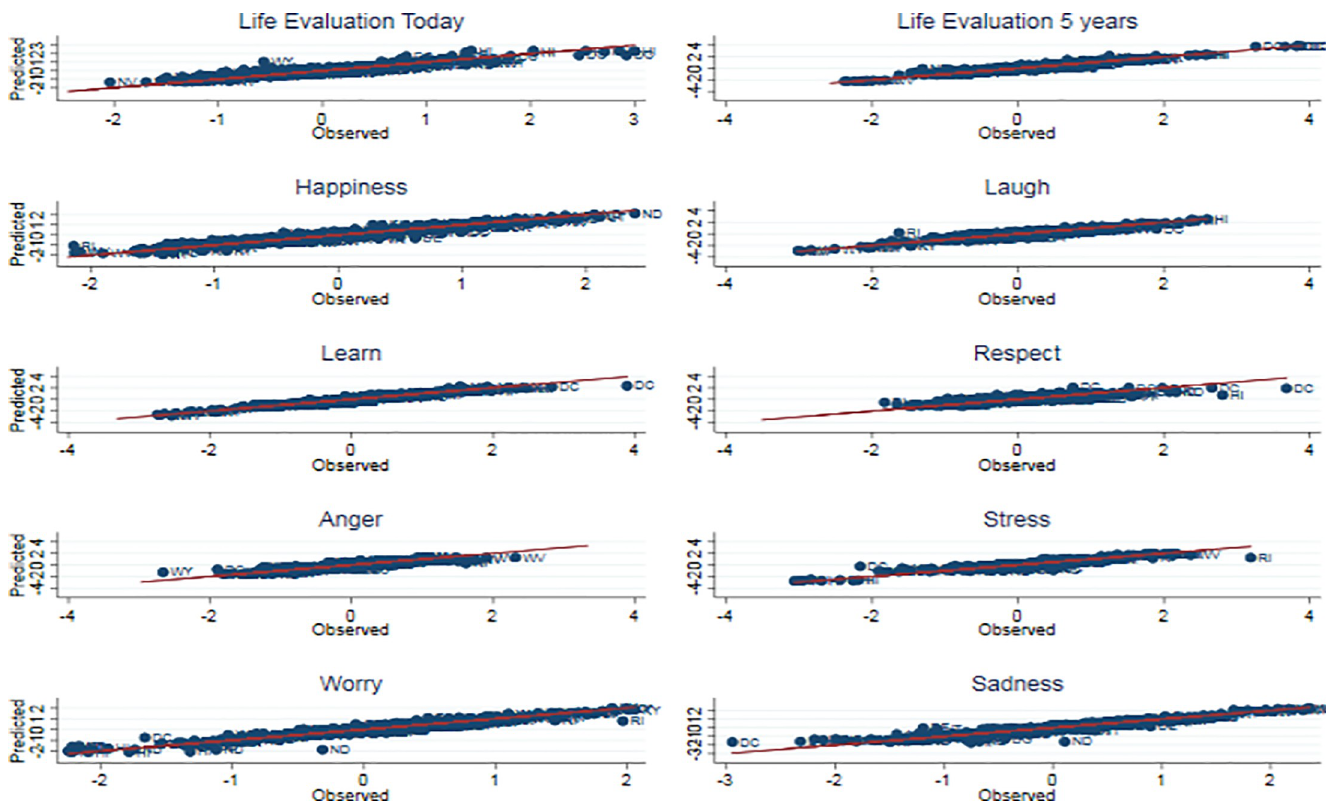
Fig 3. Biannual predicted subjective well-being and biannual Gallup data at state level, training and test samples (2008–2013). The figure shows a scatterplot of the predicted life evaluation today (y-axis) and Gallup surveyed life evaluation today (x-axis) at the biannual state level, both series normalized with mean 0 and standard deviation 1. Correlations are given in Table